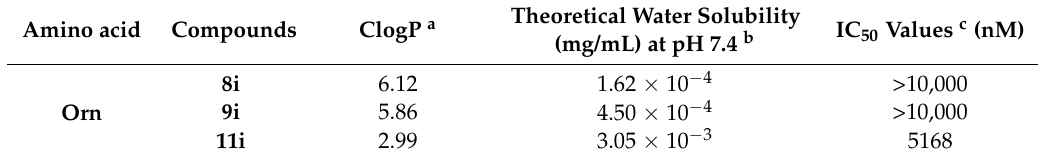
Table 2. Synthesis of imidazo[1,2- a ]quinoxaline derivatives grafted with the side chain amine of ornithine as described in Scheme 3: ClogP, theoretical water solubility (mg/mL) at pH 7.4 calculated